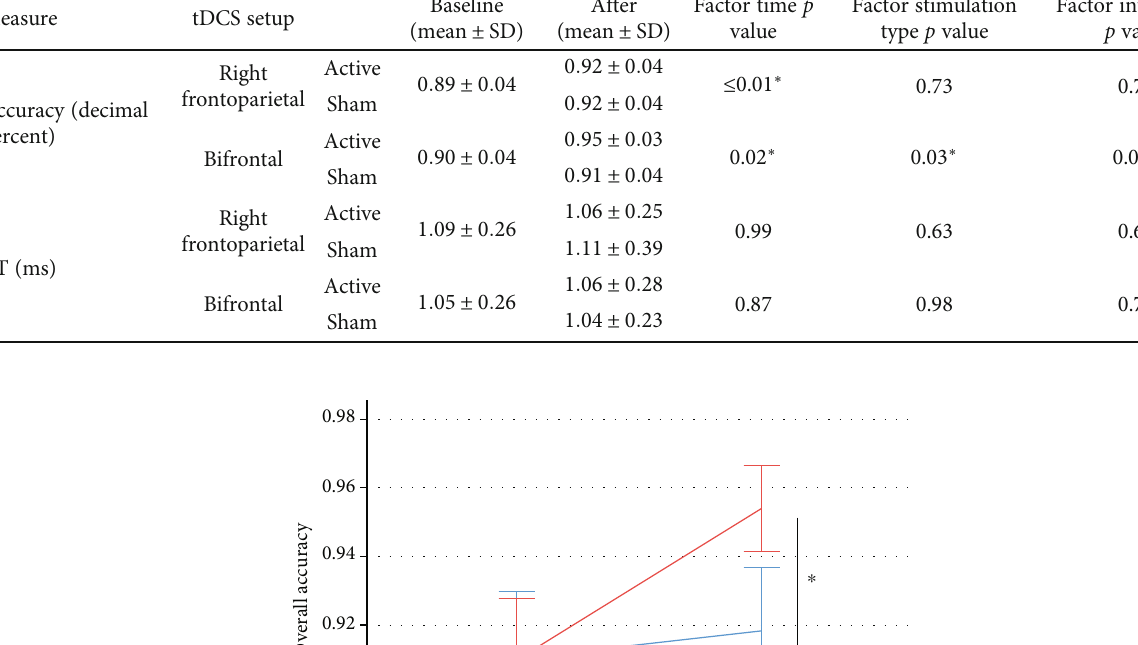
Table 2: Behavioral results in the main behavioral outcome VOMT.